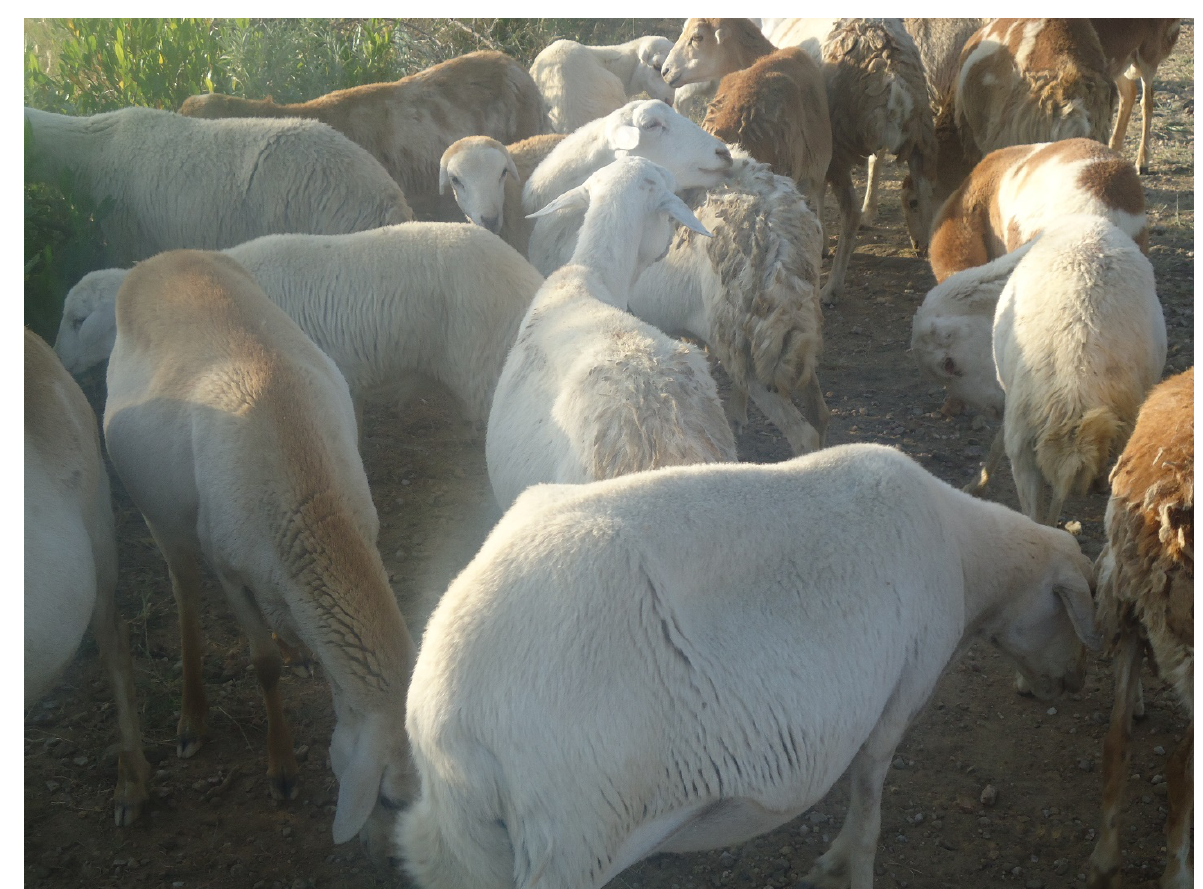
Figure 6. Lowland sheep flock in Tahtay Maichew